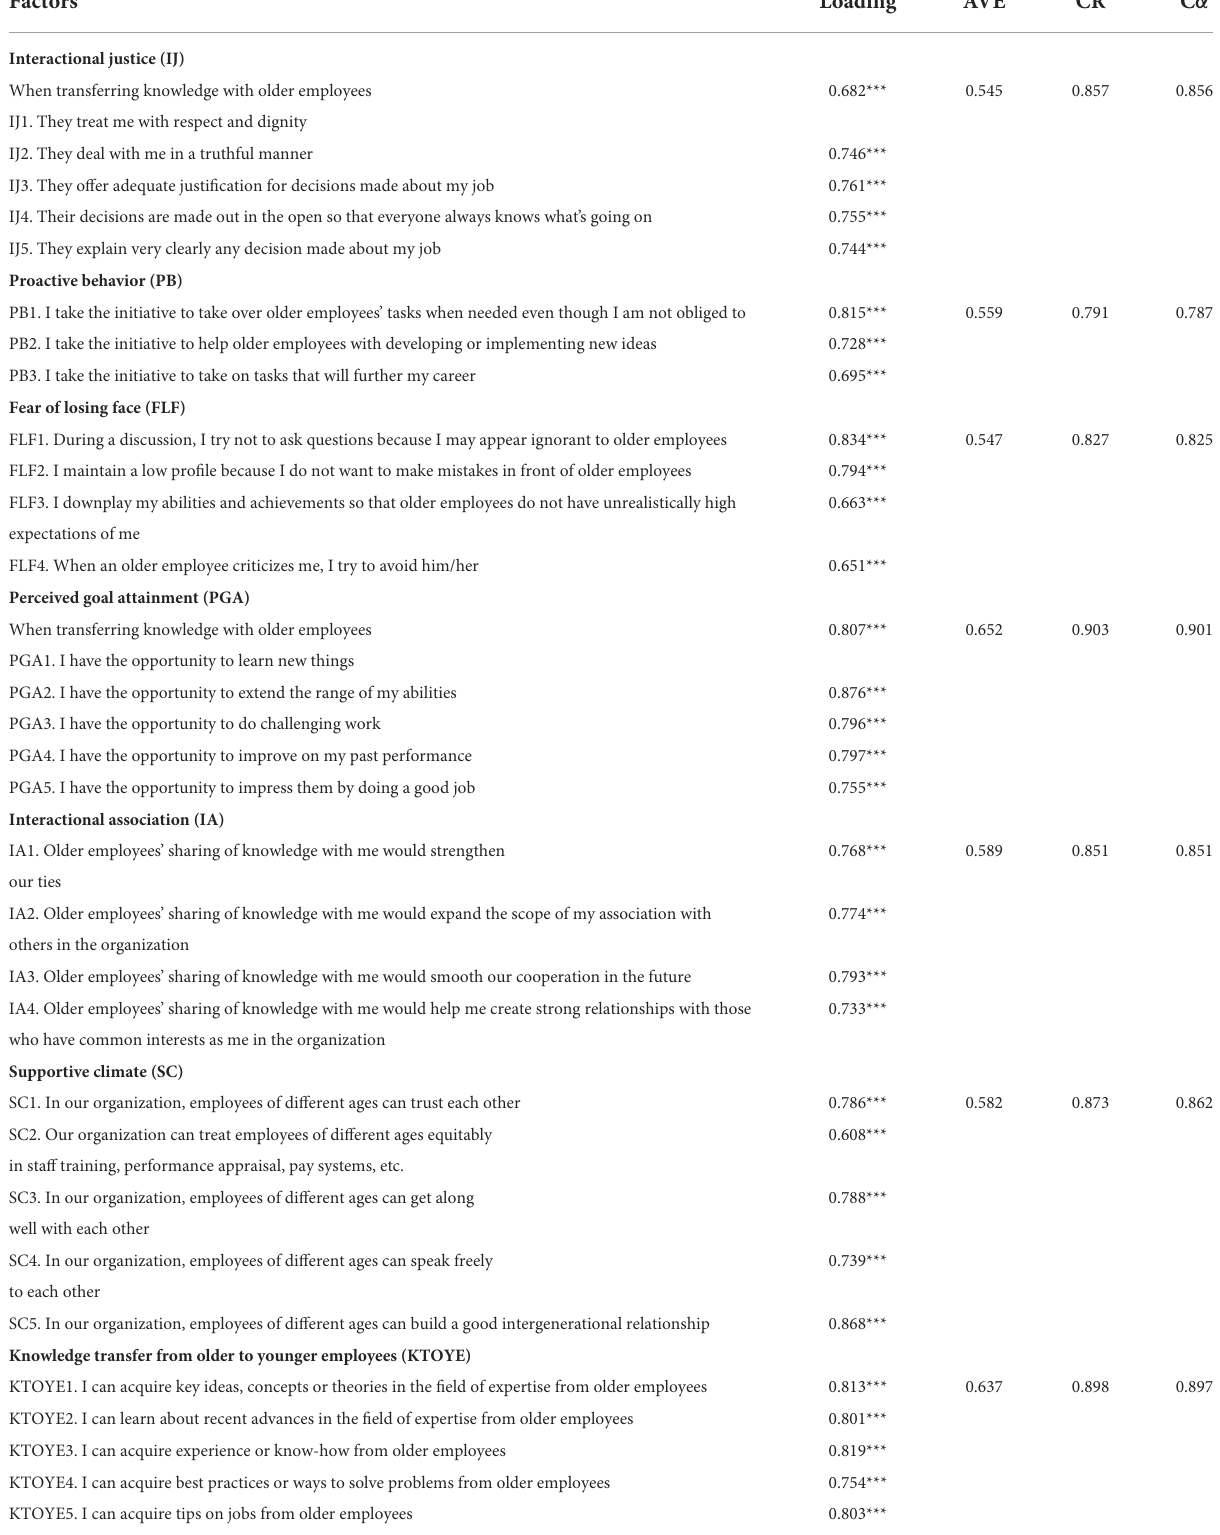
TABLE 3 Validity and reliability of the measurement